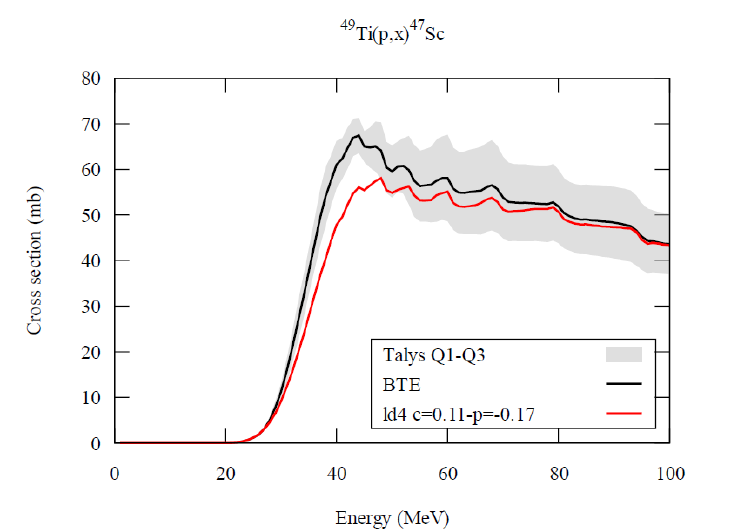
Fig. 2. Calculated cross sections for the reaction 49 Ti(p,x) 47 Sc. No data are available, and the choice of the c and p parameters is based on the tuning performed to reproduce 46 Sc data (Fig. 1).